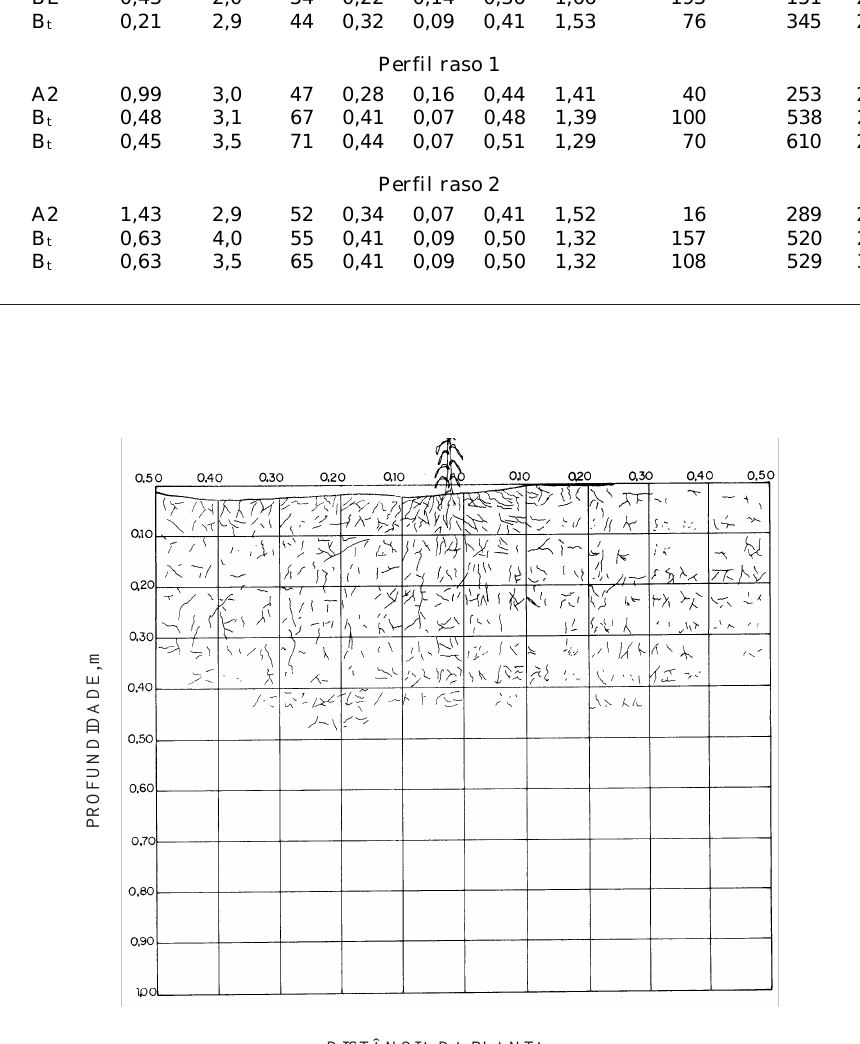
Figura 1. Distribuição radicular da cultura do milho no perfil cultural com horizonte A raso. Espessura dos horizontes: Ap1: 0-0,18 m; A2: 0,18-0,30 m; E: 0,30-0,45 m; B